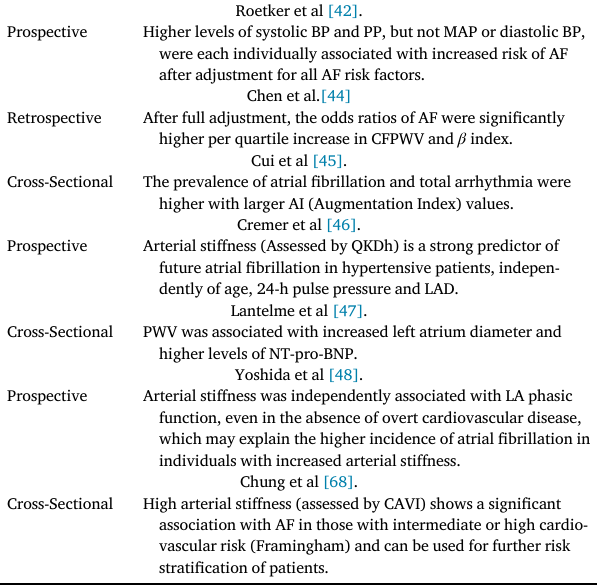
Fig. 3. Adapted from Gumprecht et al [51]. Table 2 Findings in previous observational